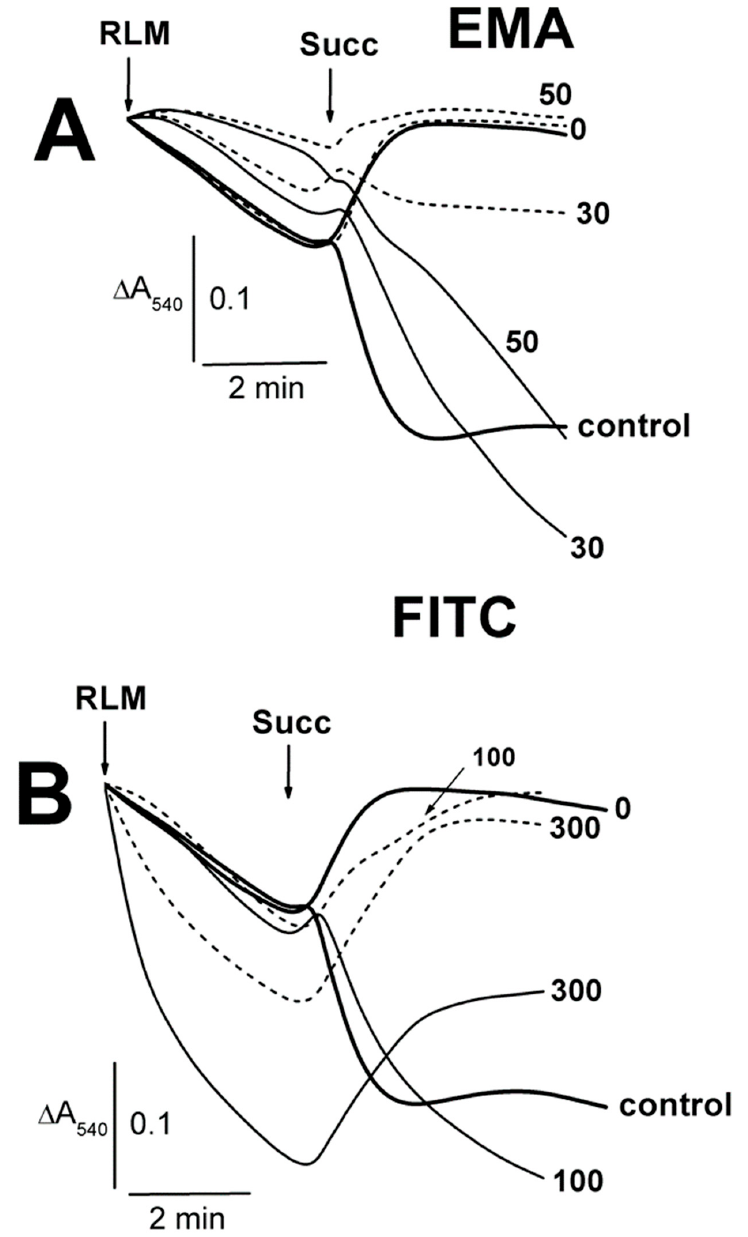
Figure 5. The influence of EMA and FITC on Tl + -induced swelling of rat liver mitochondria in the presence of Ca 2+ . Mitochondria (1.5 mg/mL of protein) were added into the medium A containing 75 mM TlNO 3 and 75 µ M Ca 2+ . The numbers on the right of the traces show concentrations ( µ M) of EMA ( A ) or FITC ( B ), injected into the medium before mitochondria. Additions of mitochondria (RLM) and 5 mM succinate (Succ) are shown by arrows. The medium was additionally supplemented by 500 μ M ADP (short dash traces). The bold traces show experiments free of Ca 2+ (0) or ones with Ca 2+ alone (control).